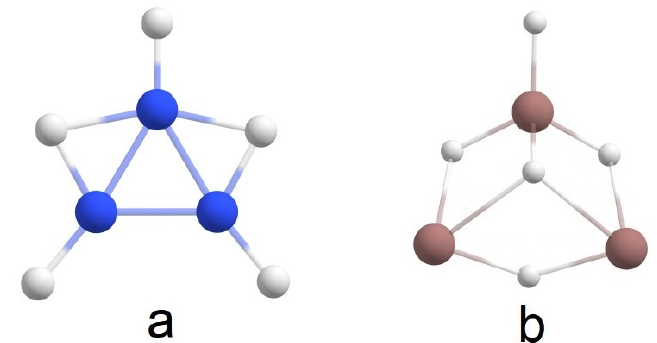
Figure 10. The comparison of the global minimum structures for ( a ) B 3 H 5 (according to [4]) and ( b ) In 3 H 5 .